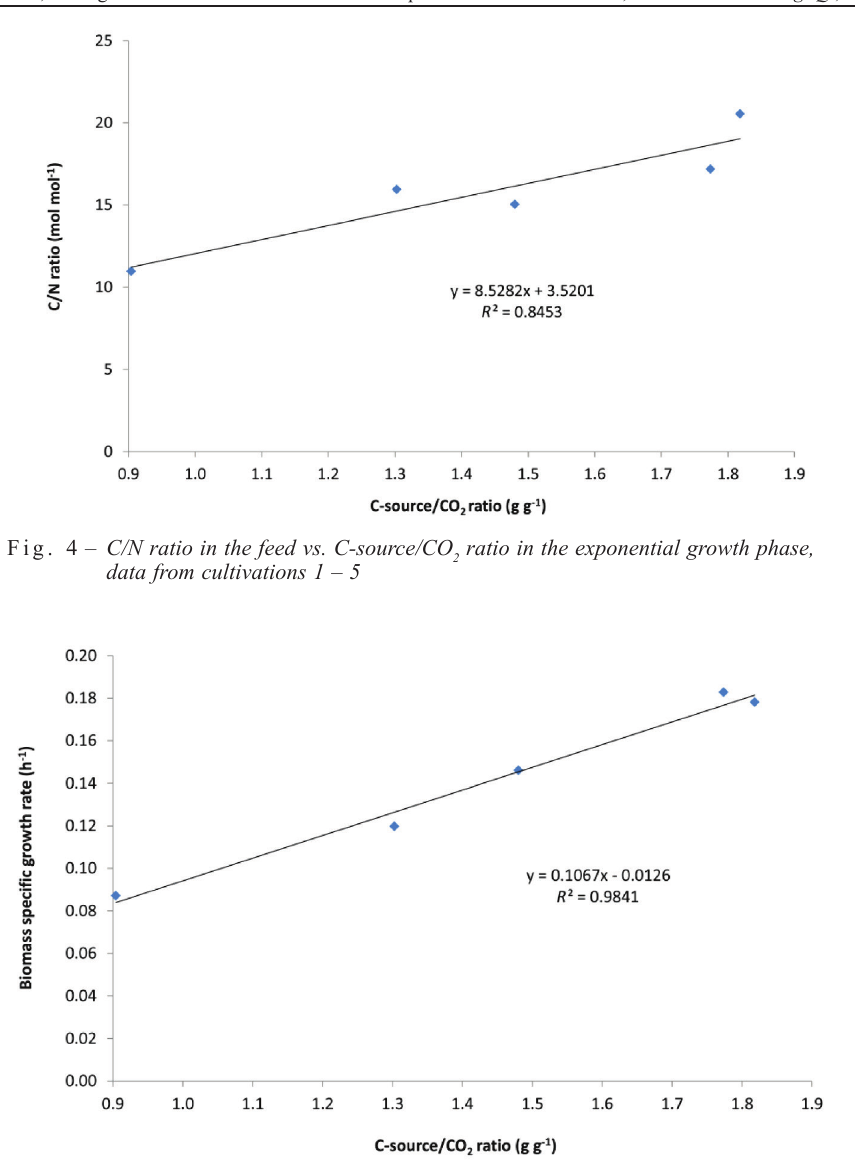
Fig. 5 – Overall specific biomass growth rate vs. C-source/CO growth phase, data from cultivations 1 –